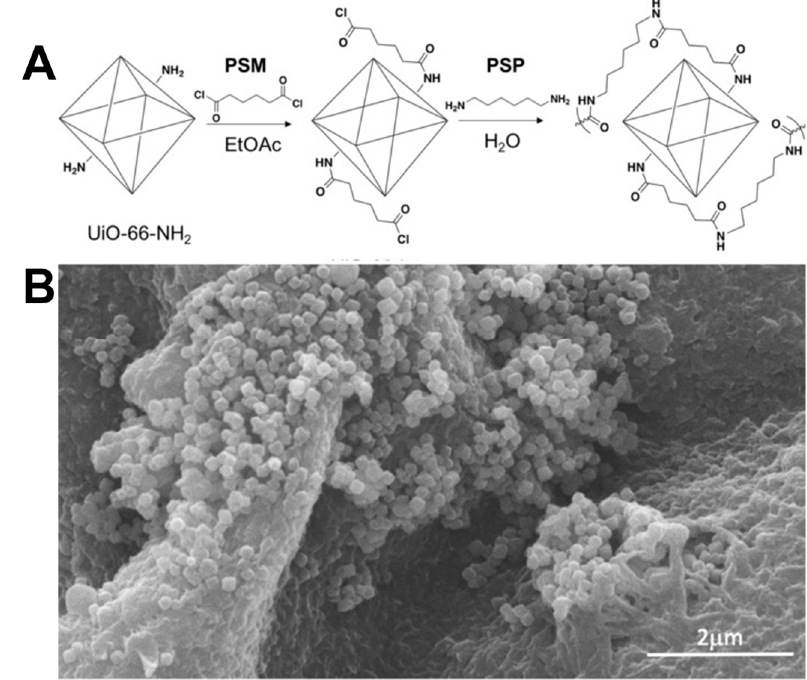
Figure 12 . ( A ) Schemes of PSM and PSP used to prepare PA-66-UiO-66-NH 2 . ( B ) SEM image of PA-66-UiO-66-NH 2 . Reproduced with permission from Ref. [152] Copyright 2012, John Wiley & sons. Polymers 2019 , 11 , x FOR PEER REVIEW